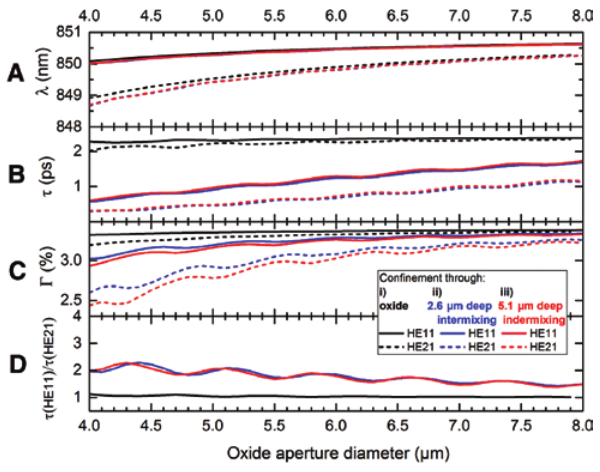
Figure 13: Simulation of the (A) wavelength, (B) lifetime, (C) con- finement factor, and (D) lifetime ratio of the fundamental mode and the first excited modes of an (i) oxide-confined and an intermixing- confined VCSEL of the same design, with different intermixing depths of (ii) 2.6 μ m and (iii) 5.2 μ m.